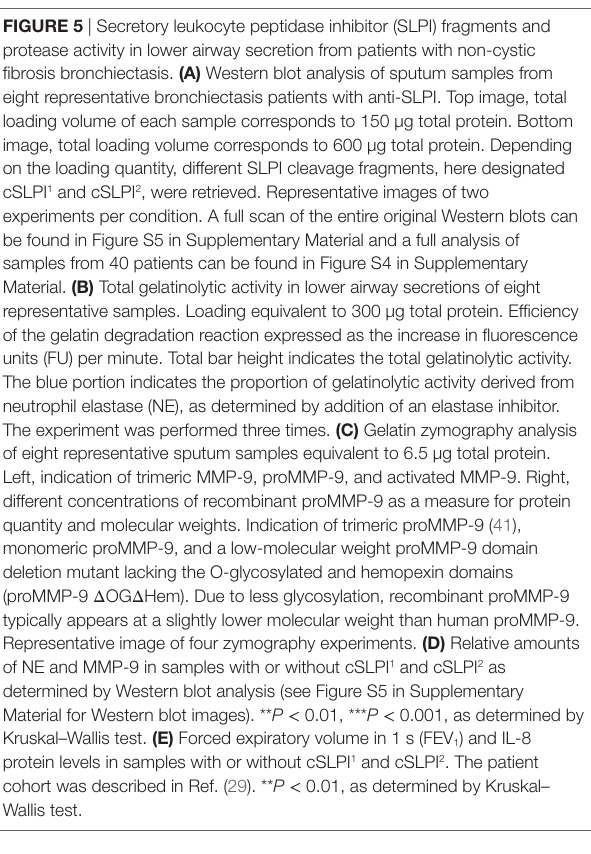
FigUre 5 | Secretory leukocyte peptidase inhibitor (SLPI) fragments and protease activity in lower airway secretion from patients with non-cystic fibrosis bronchiectasis. (a) Western blot analysis of sputum samples from eight representative bronchiectasis patients with anti-SLPI. Top image, total loading volume of each sample corresponds to 150 µg total protein. Bottom image, total loading volume corresponds to 600 µg total protein. Depending on the loading quantity, different SLPI cleavage fragments, here designated cSLPI 1 and cSLPI 2 , were retrieved. Representative images of two experiments per condition. A full scan of the entire original Western blots can be found in Figure S5 in Supplementary Material and a full analysis of samples from 40 patients can be found in Figure S4 in Supplementary Material. (B) Total gelatinolytic activity in lower airway secretions of eight representative samples. Loading equivalent to 300 µg total protein. Efficiency of the gelatin degradation reaction expressed as the increase in fluorescence units (FU) per minute. Total bar height indicates the total gelatinolytic activity. The blue portion indicates the proportion of gelatinolytic activity derived from neutrophil elastase (NE), as determined by addition of an elastase inhibitor. The experiment was performed three times. (c) Gelatin zymography analysis of eight representative sputum samples equivalent to 6.5 µg total protein. Left, indication of trimeric MMP-9, proMMP-9, and activated MMP-9. Right, different concentrations of recombinant proMMP-9 as a measure for protein quantity and molecular weights. Indication of trimeric proMMP-9 (41), monomeric proMMP-9, and a low-molecular weight proMMP-9 domain deletion mutant lacking the O-glycosylated and hemopexin